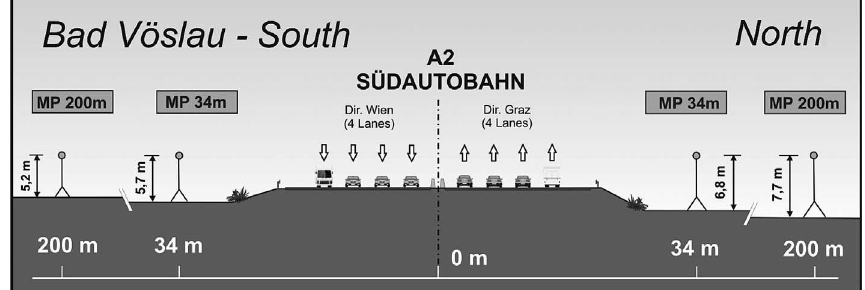
Figure 6. Motorway measurement location near Bad